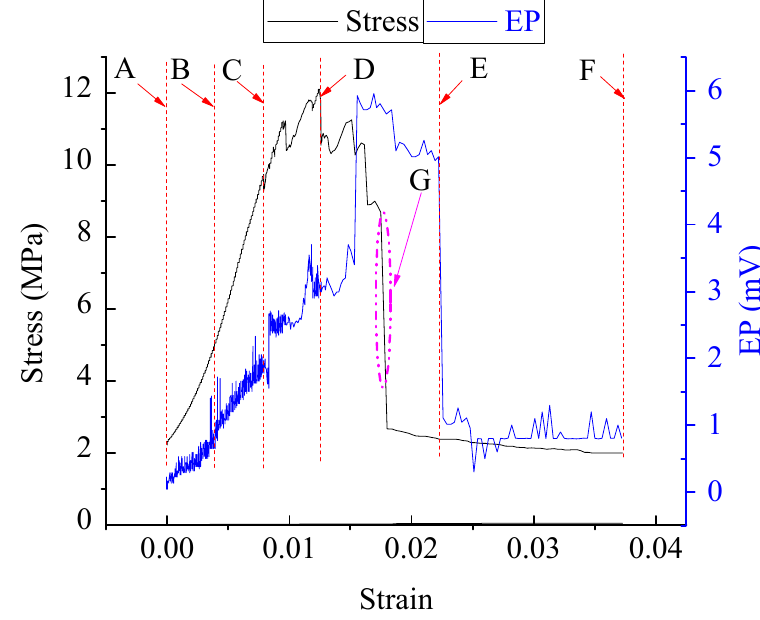
Figure 17. Complete stress-strain curves during the damage of gas-bearing coal under load.